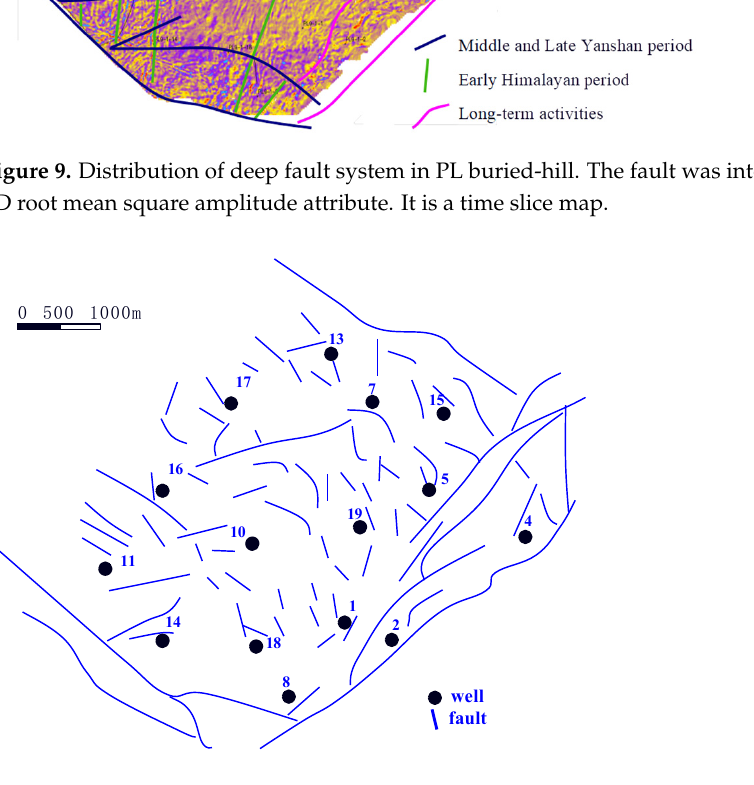
Figure 10. Distribution map of shallow fault system in PL buried-hill (top surface of buried-hill). The fault was interpreted based on 3D post-stack seismic data.